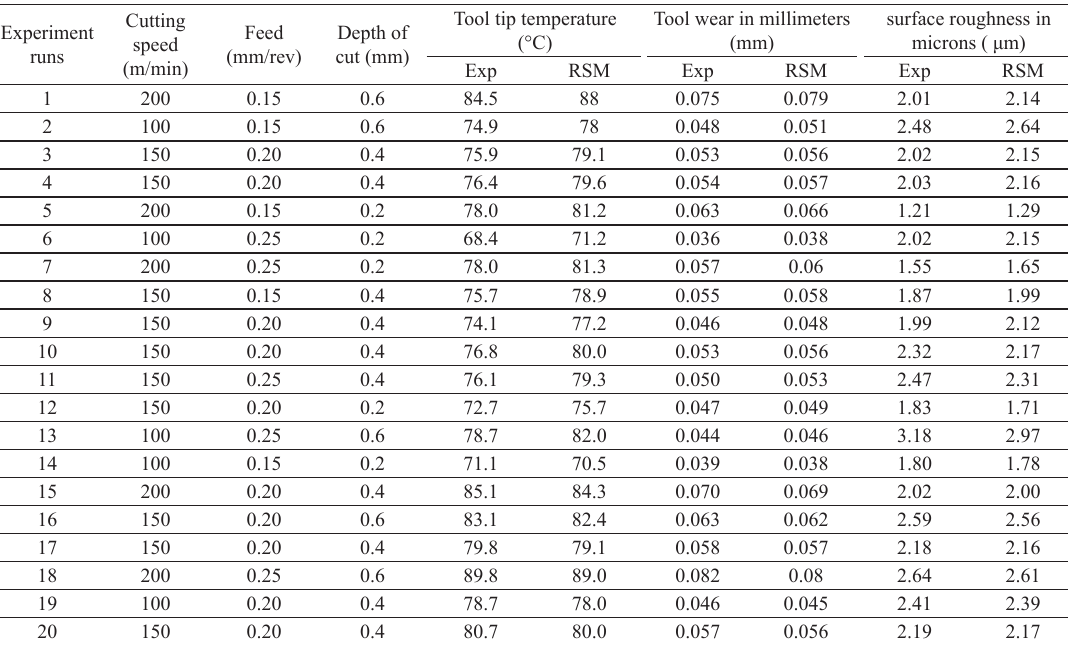
Table 4. Experimental outcome and optimized